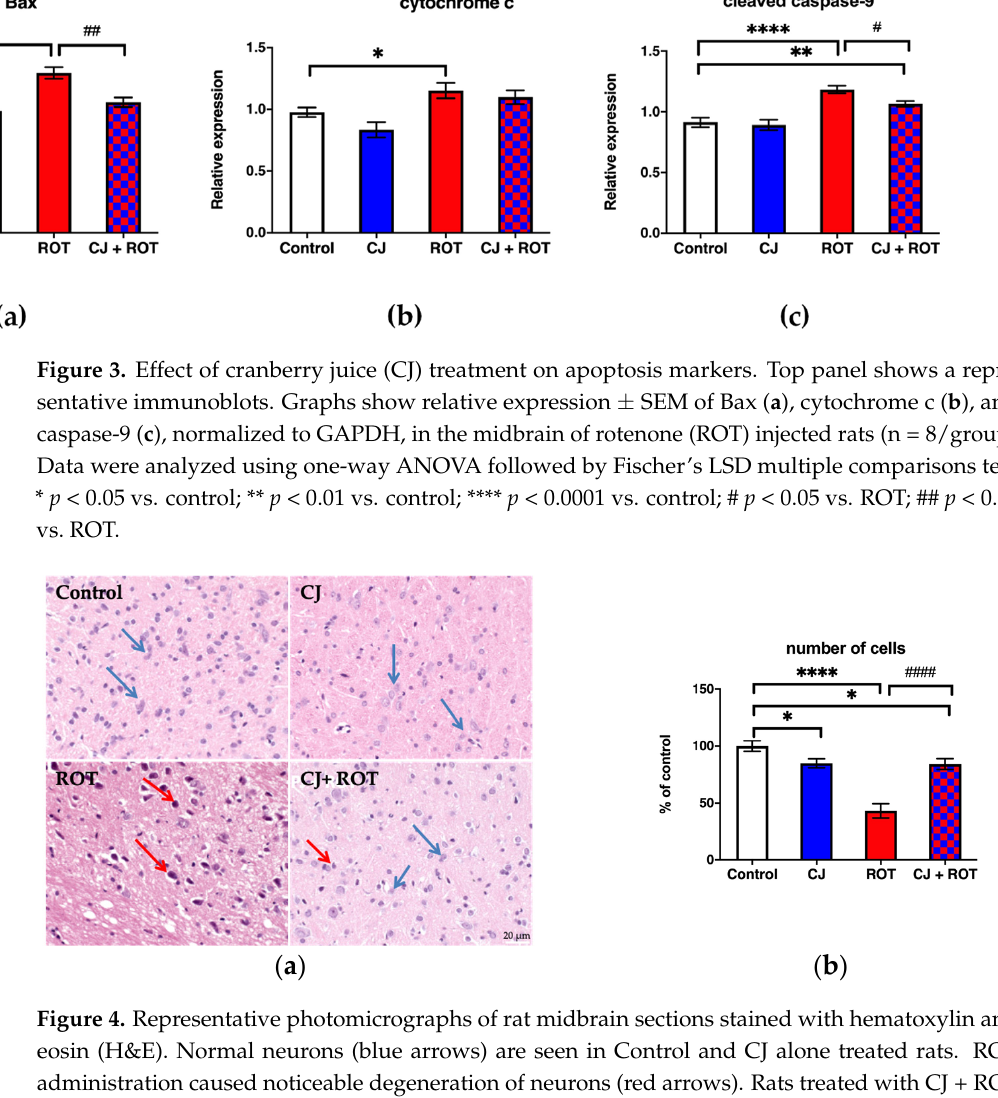
Figure 3. Effect of cranberry juice (CJ) treatment on apoptosis markers. Top panel shows a representative immunoblots. Graphs show relative expression ± SEM of Bax ( a ), cytochrome c ( b ), and caspase-9 ( c ), normalized to GAPDH, in the midbrain of rotenone (ROT) injected rats (n = 8/group). Data were analyzed using one-way ANOVA followed by Fischer’s LSD multiple comparisons test. * p < 0.05 vs. control; ** p < 0.01 vs. control; **** p < 0.0001 vs. control; # p < 0.05 vs. ROT; ## p < 0.01 vs. ROT.